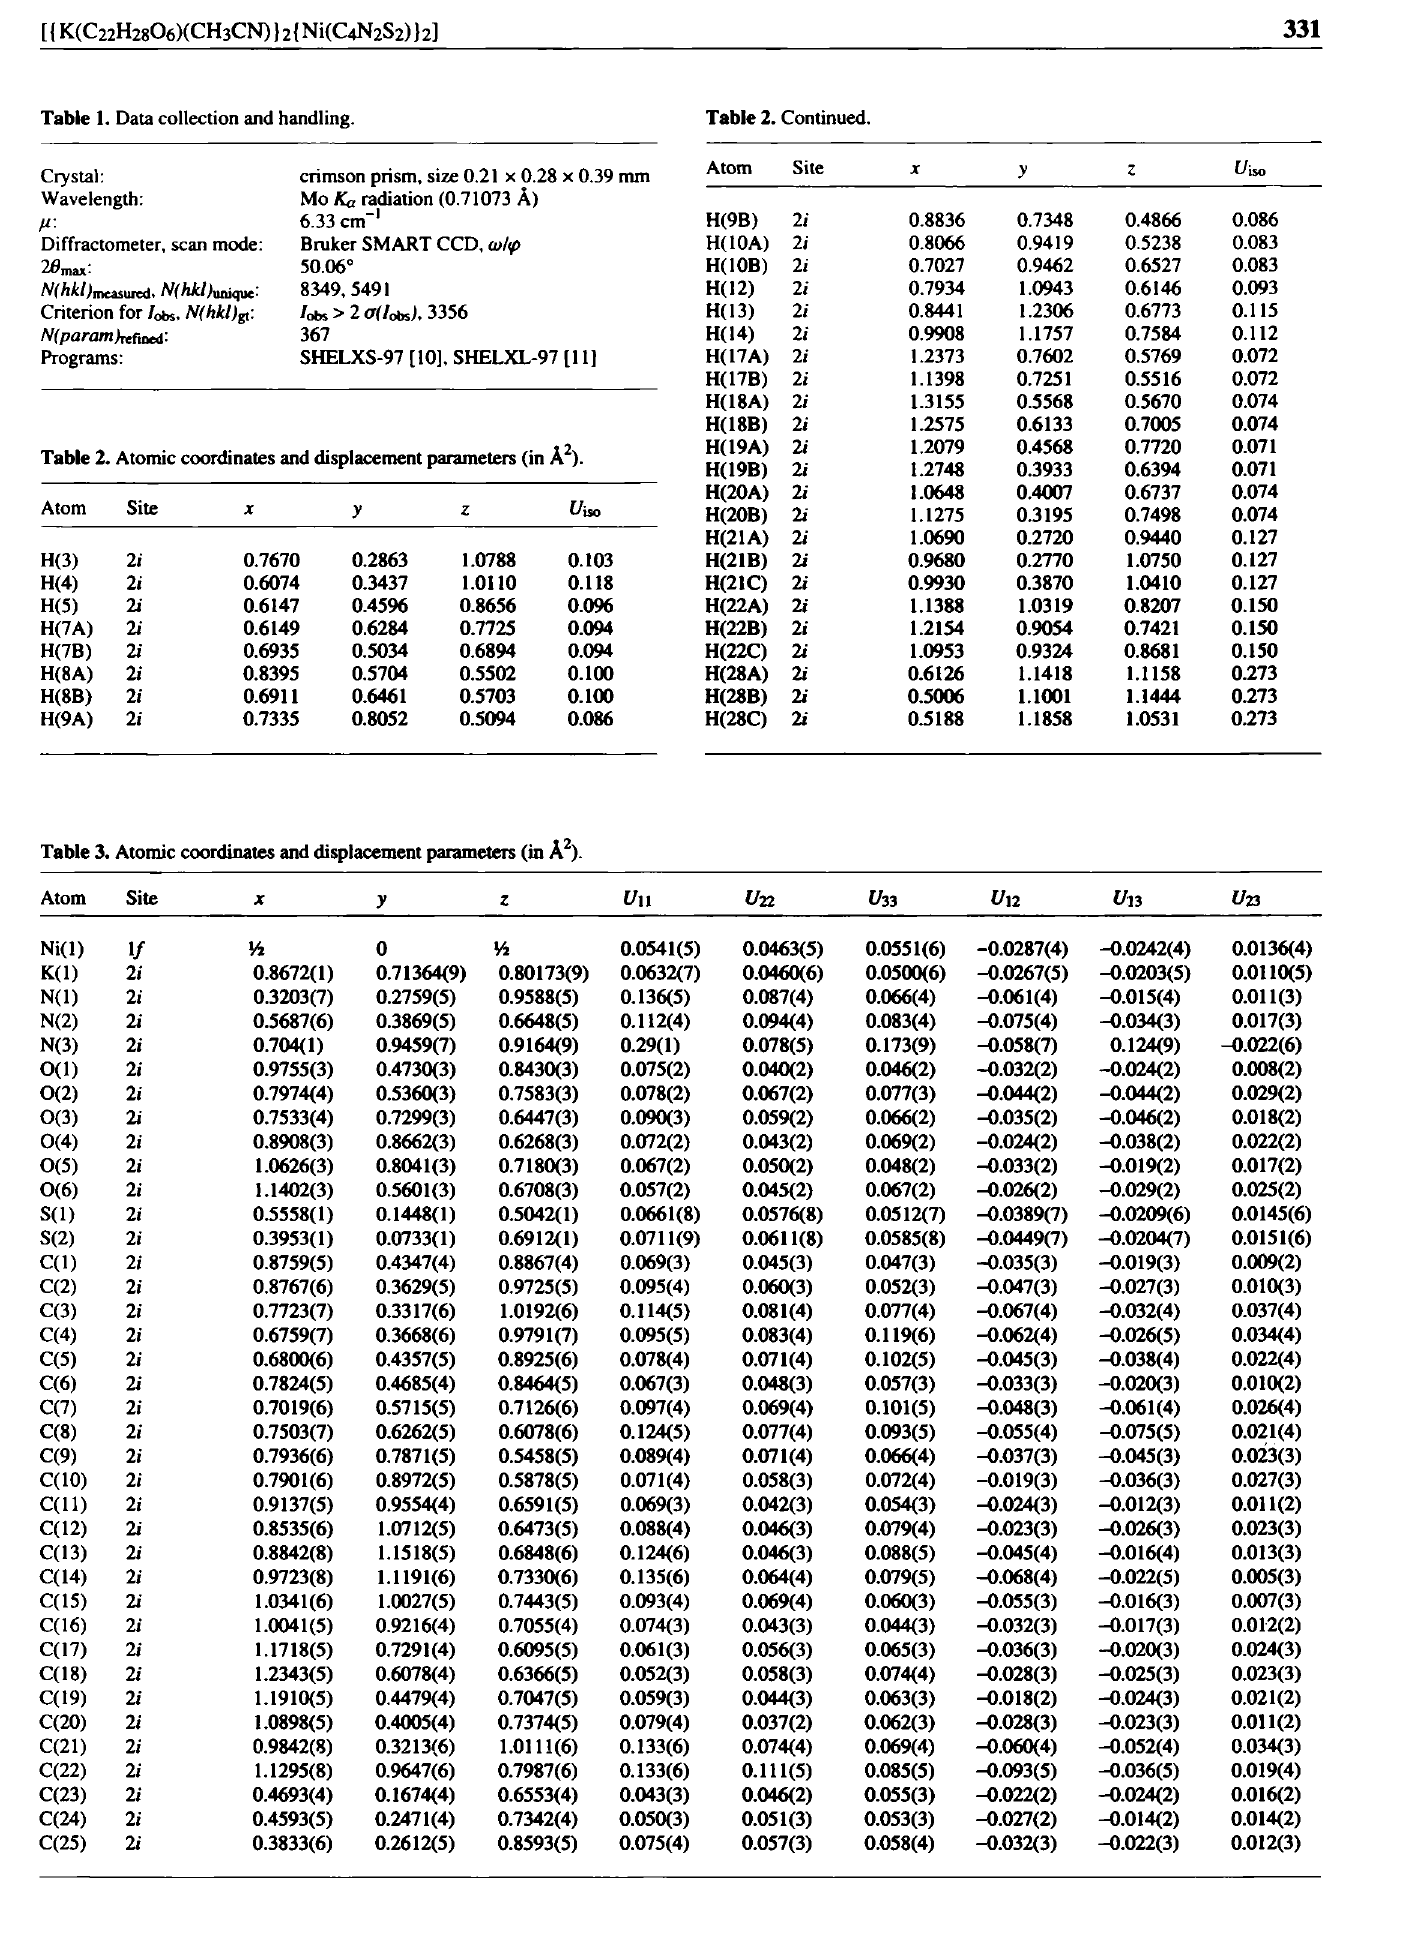
Table 1. Data collection and handling.